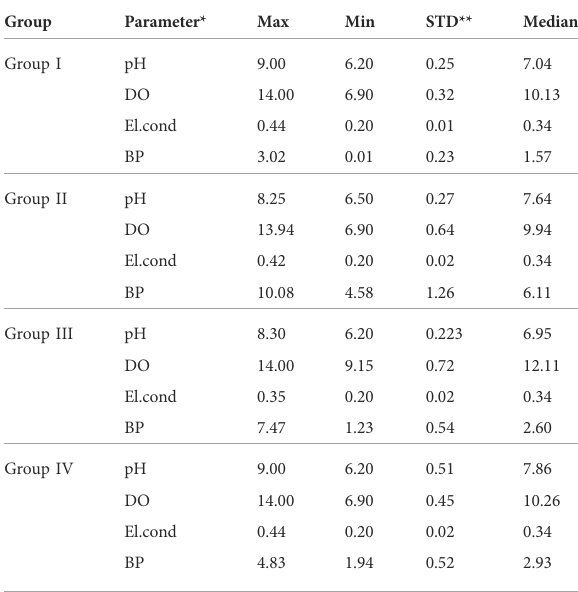
TABLE 3 Summary statistics of each